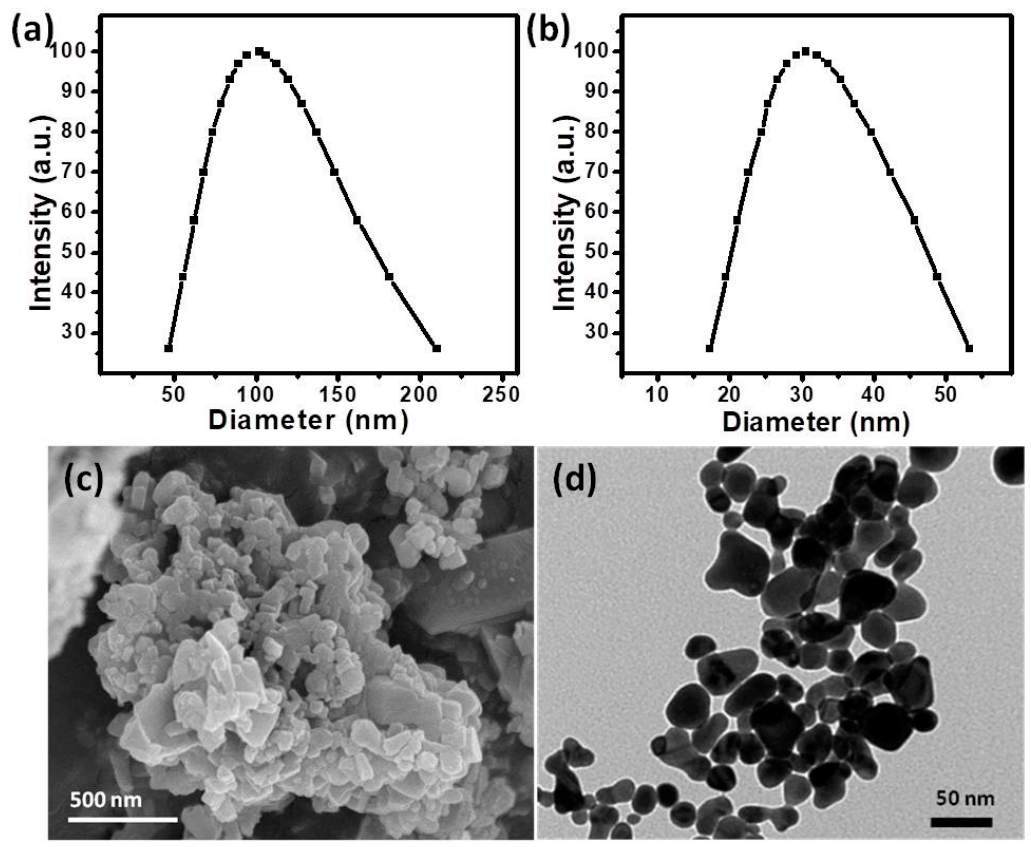
Figure 2. Particle size distributions of ( a ) CaO and ( b ) 2-Zn / CaO-400: ( c ) field emission scanning electron microscopy (FESEM) and ( d ) transmission electron microscopy (TEM) images of 2-Zn / CaO-400.